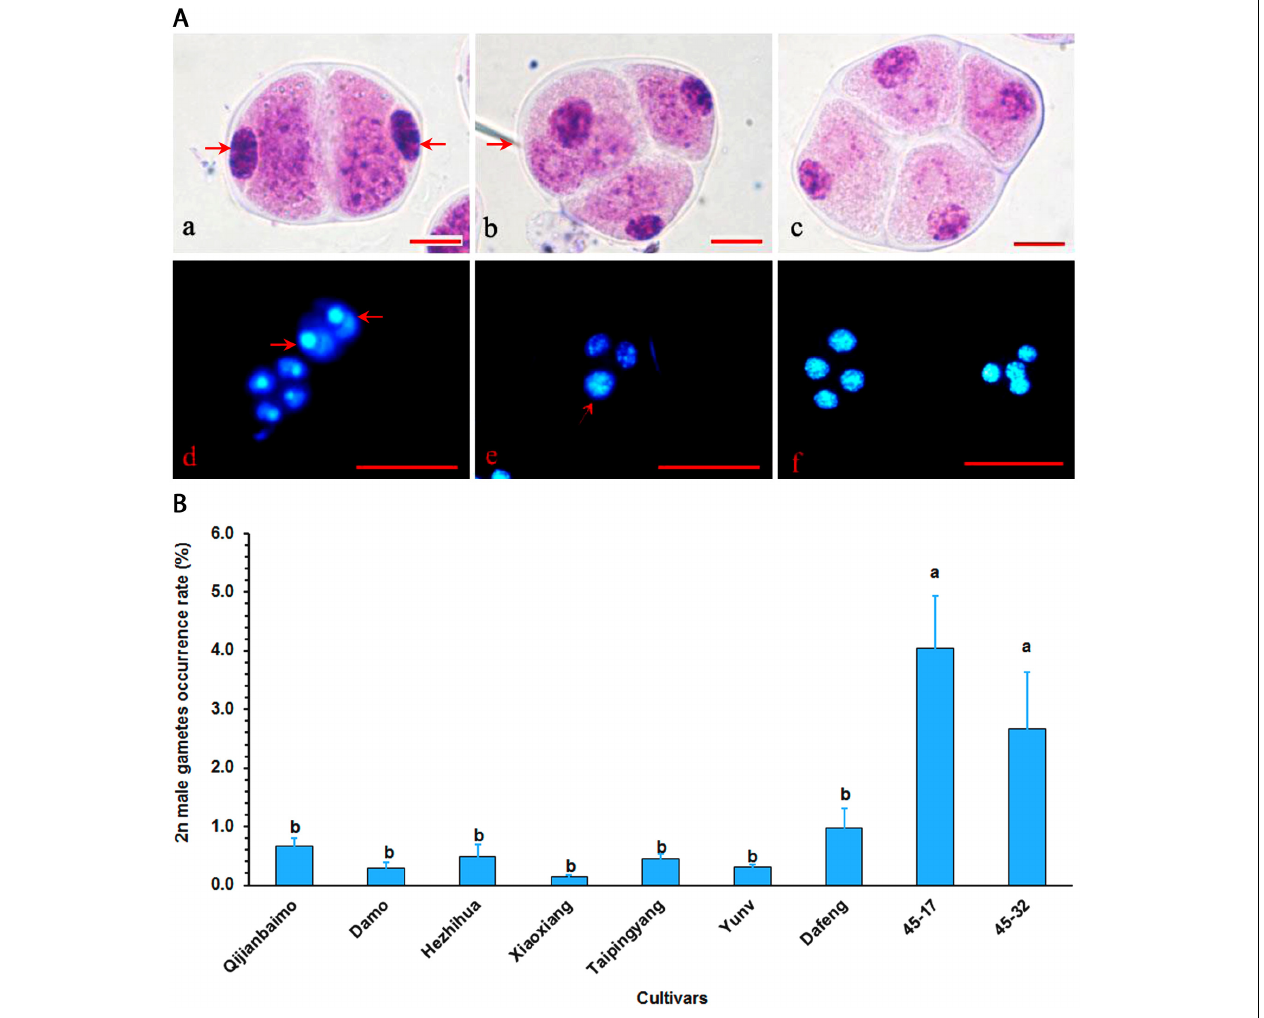
FIGURE 1 | Analysis of unreduced male gametes in Cymbidium cultivars using the squash method. (A) Mature pollens were stained with carbolfuchsin, and dyad (a), triad (b), and tetrad (c) gametes were identified by the squash method. Bar = 10 µ m. The dyad with 2 n gametes (arrow) (d), triads with one unreduced gamete (arrow) and two reduced gametes (e), and tetrad with four reduced gametes (f) were stained with 4’,6-diamidino-2-phenylindole (DAPI). Bar = 50 µ m. (B) 2 n gamete formation frequencies (means of 3-year data, Supplementary Table S1 ) among nine cultivars, bars represent standard error ( n = 30). Different letters on the top of bars indicate significant cultivar difference in 2 n gamete formation frequencies analyzed by Duncan’s multiple range test at P < 0.05